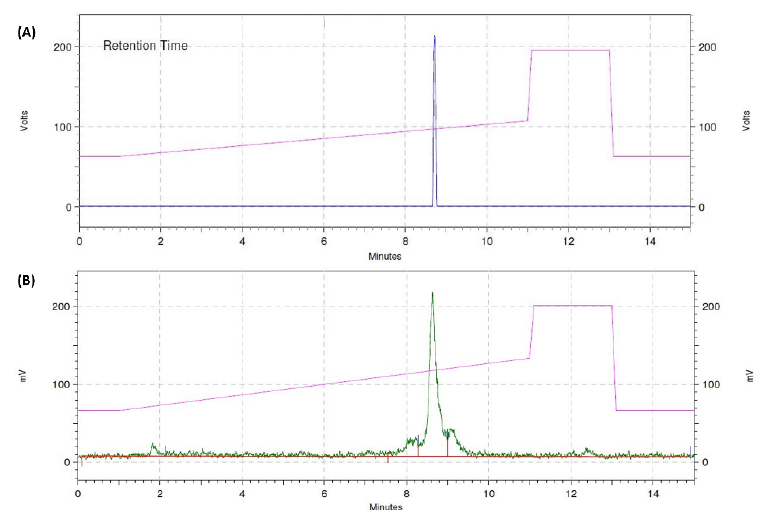
Figure 2. The representative UV chromatogram of the non-labeled BO530 ( A ) and the radio chromatogram of BO530 after radiolabeling with I-125 ( B ).